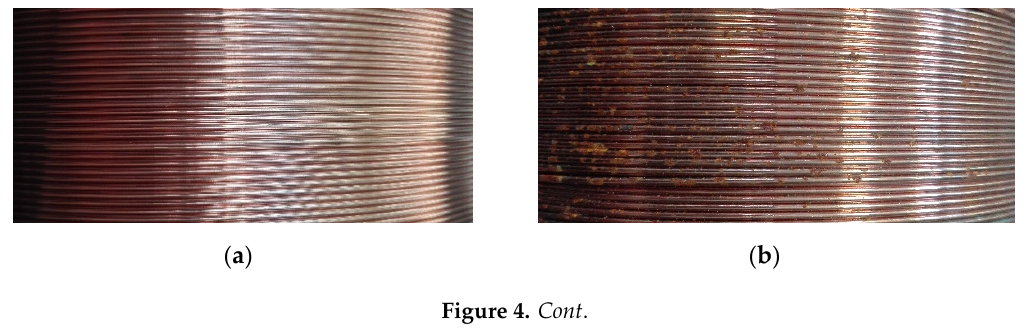
Figure 3. Ambient humidity changes during wires storage—Gdańsk welding site (GWS) and Mońki agricultural building (MAB)—1 month.